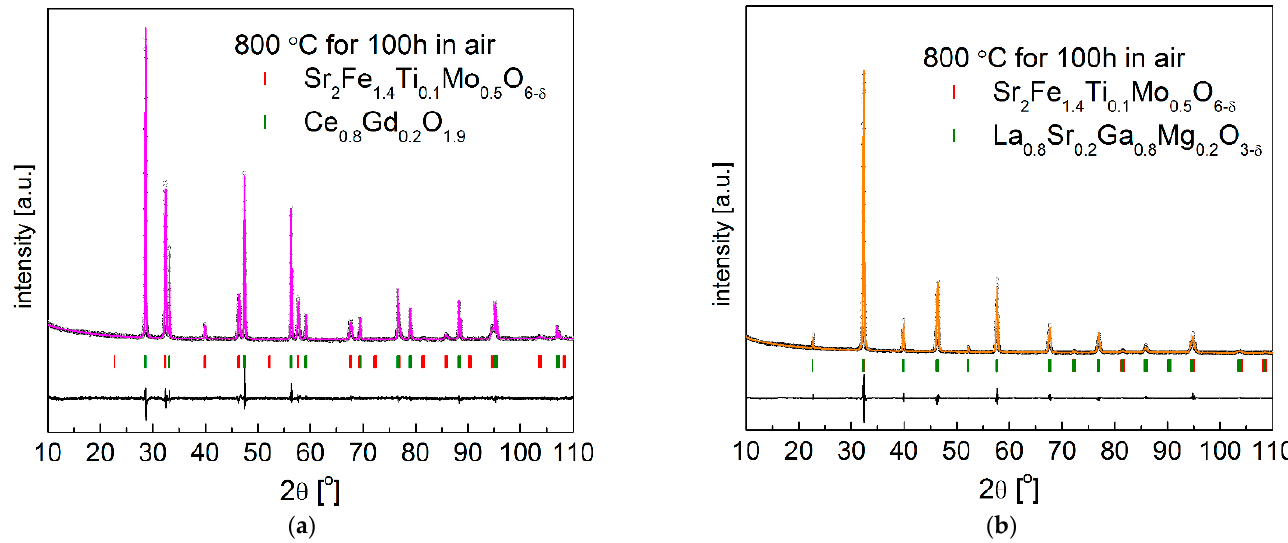
Figure 11. XRD patterns recorded for ( a ) Sr 2 Fe 1.4 Ti 0.1 Mo 0.5 O 6 − δ with Ce 0.8 Gd 0.2 O 1.9 ; ( b ) Sr 2 Fe 1.4 Ti 0.1 Mo 0.5 O 6 − δ with La 0.8 Sr 0.2 Ga 0.8 Mg 0.2 O 3 − δ electrolyte, after firing for 100h at 800 ◦ C in Table 5. Structural parameters of Sr 2 Fe 1 . 4 Ti 0 . 1 Mo 0 . 5 O 6 −δ sample with Ce 0 . 8 Gd 0 . 2 O 1 . 9 and with